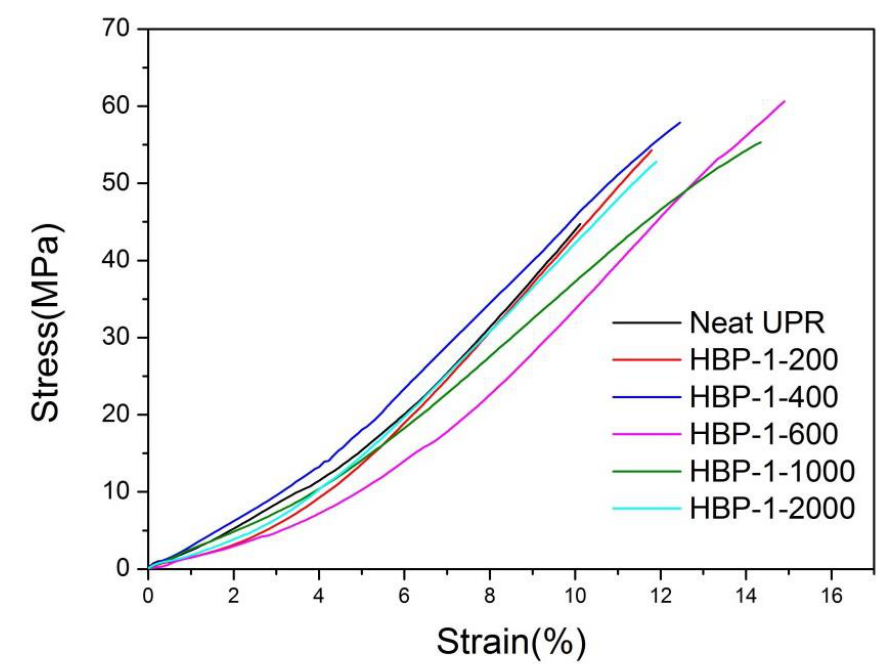
Figure 5. Representative tensile stress–strain curves of neat UPR and the UPR composites.